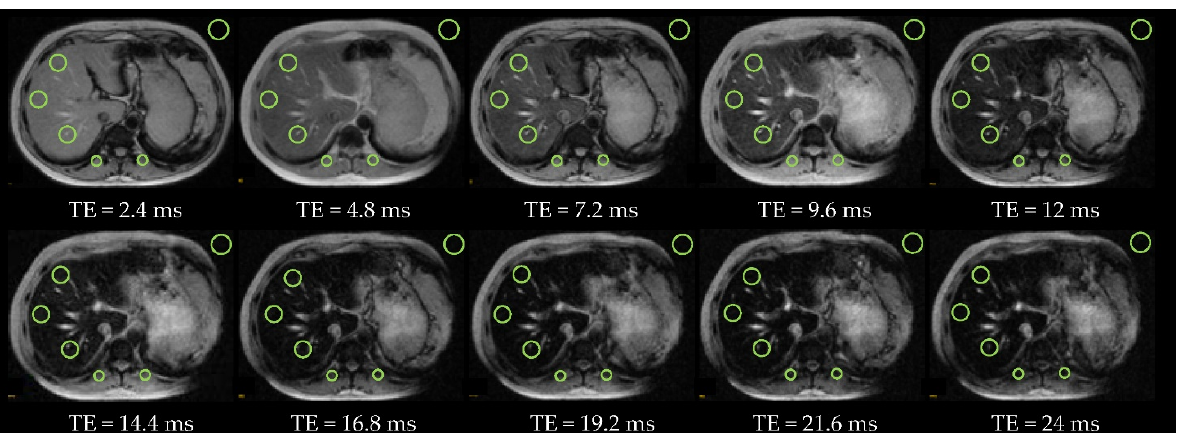
Figure 8. Patient #3 with absence of iron overload and steatosis at 3T ( T2 * = 16.1 ms and LIC = 19 µmol/g). There are 12 echoes with a duration of 1.2 ms each one. The OOP images are with TE = 1.2 ms, 3.6 ms, 6 ms, 8.4 ms, 10.8 ms, and 15.6 ms and IP images are with TE = 2.4 ms, 4.8 ms, 7.2 ms, 9.6 ms, 12 ms, and 14.4 ms. There are 3 ROis in the liver, 2 ROIs in paravertebral muscles, 1 ROI in the spleen and 1 ROI of background noise.